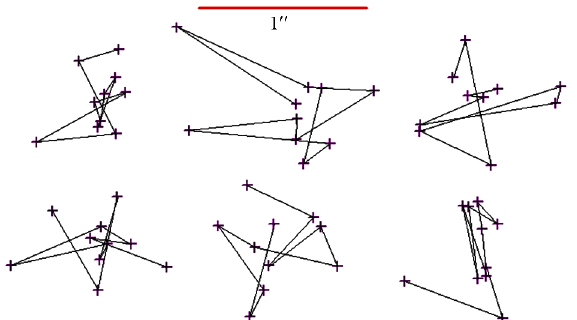
Figure 2. Position of corrected zenith point on CCD (orientation arbitrary) for 6 consecutive positions around minute 180 of sample session. Consecutive frames connected by